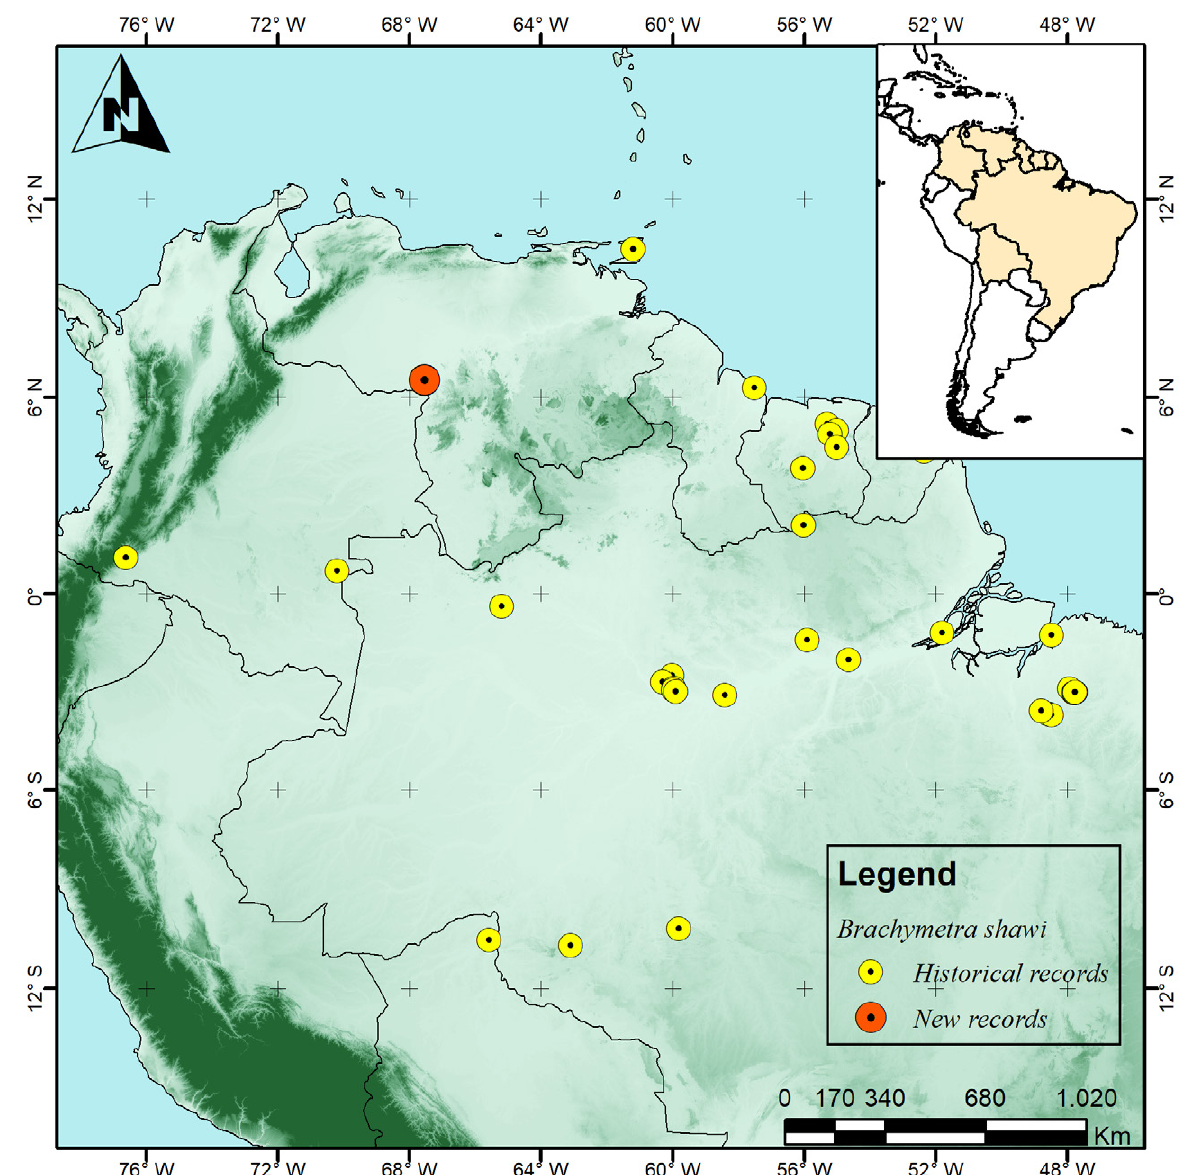
Figure 3. Historical and new records of Brachymetra shawi in the